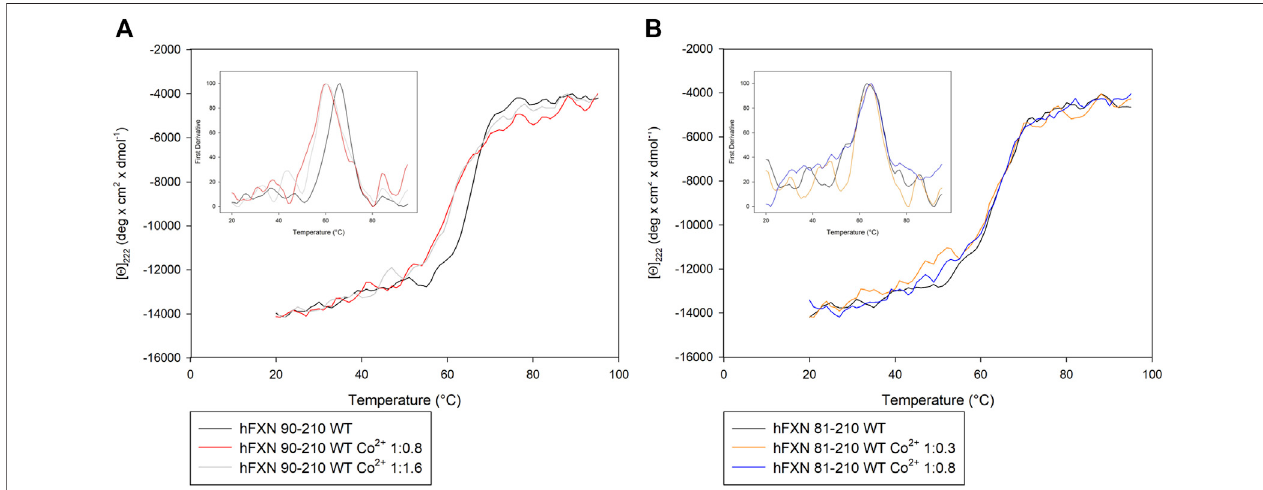
FIGURE 3 | Thermal unfolding transition ofFXN isoforms with and without Co 2+ . (A) Thermal unfolding curves of FXN 90-210 in the absence of Co 2+ (black) and in thepresenceof0.8(red)or1.6(grey)Co 2+ equiv. (B) Thermalunfolding curvesofFXN81-210 intheabsenceofCo 2+ (darkpurple)and inthepresenceof0.3(orange)or 0.8(blue)Co 2+ equiv.Thecurvesareobtainedbymonitoringthemolarellipticityat222 nm[ Θ ] 222 ,intherangebetween20and95 ° C.Insetsshowthe fi rstderivativeofthe experimental curve.